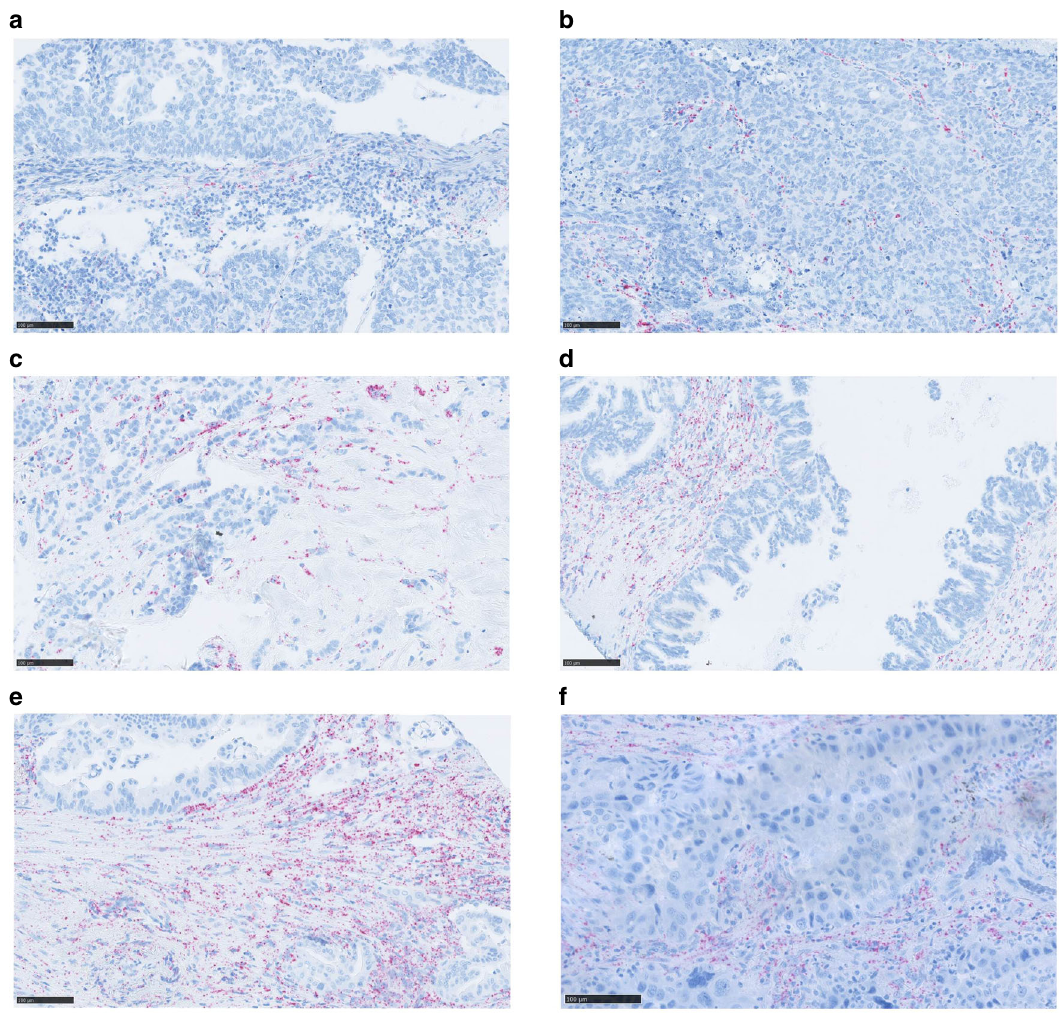
Fig. 6 RNA chromogenic in situ hybridization (CISH) for ciRS-7 in various adenocarcinomas. a – f The adenocarcinomas are derived from a tissue microarray and are originating from cervix ( a ), lung ( b ), breast ( c ), ovarium ( d ), pancreas ( e ), and stomach ( f ). For each cancer type at least two cores containing both cancer cells and tumor stroma were analyzed and showed similar results. The ciRS-7 signal (red dots) is observed in the tumor stroma whereas the cancer cells are negative. Scale bars, corresponding to 100 µ m, are indicated in the lower-left